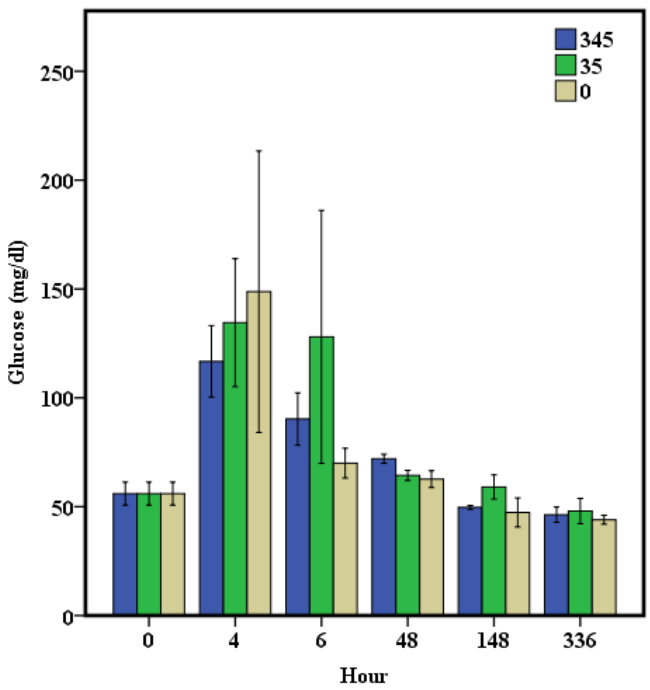
Figure 2. Trial 2 glucose levels ( ± SE) at the beginning (hour 0—before transfer, hardness of 345 mg/L) and 4, 6, 48, 120, and 336 hours after the start of the trial when rainbow trout Oncorhynchus mykiss ( n = 4 for each treatment at each timepoint) were directly transferred from 345 mg/L water hardness to experimental conditions without acclimation. Fishes 2022 , 7 , x FOR PEER REVIEW